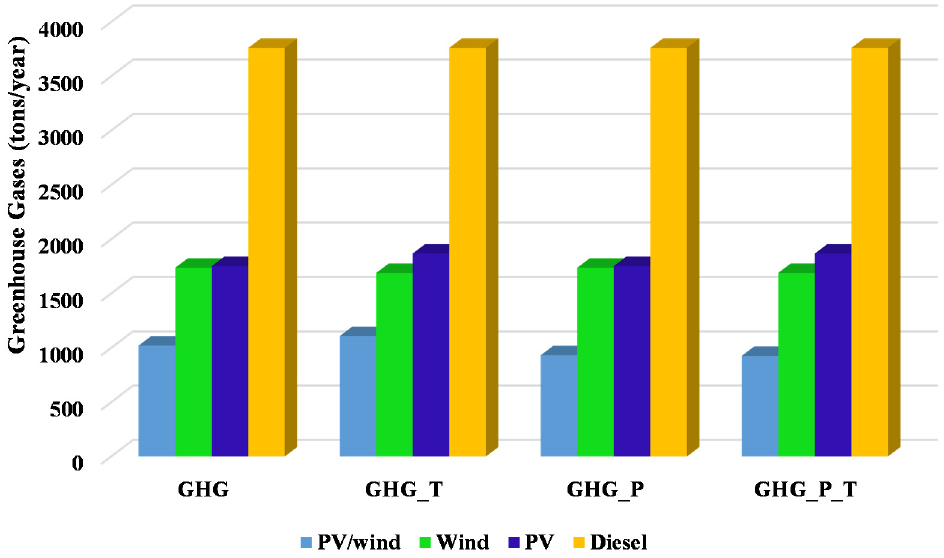
Figure 2. The different amounts of greenhouse gases (GHG) emitted by PV/wind/diesel/battery, wind/diesel/battery, PV/diesel/battery and diesel/battery systems